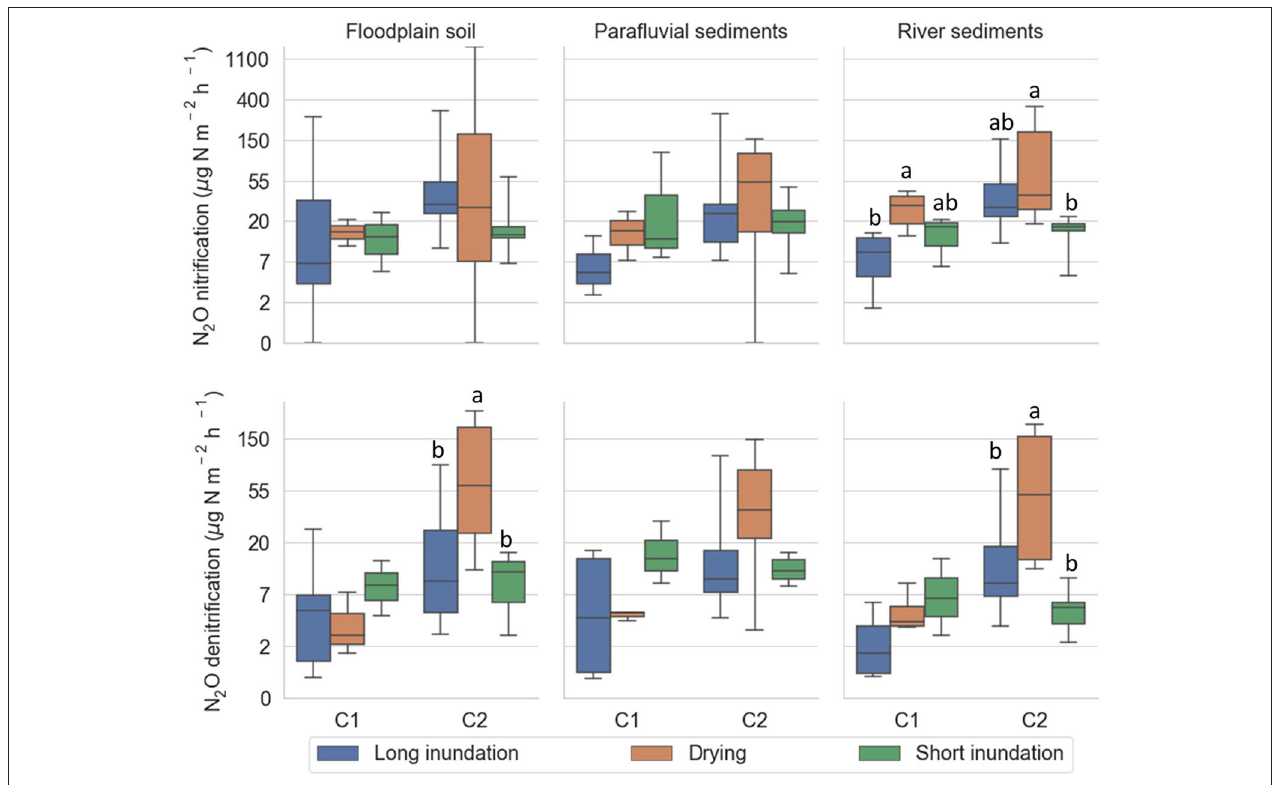
FIGURE 6 | N 2 O fluxes derived from nitrification (A) and denitrification (B) per site (floodplain soil, parafluvial sediments, river sediments), for each phase (long inundation, drying phase, short inundation phase). The data is aggregated by cycle (cycle 1 and 2). For each cycle, the treatment cores were subject to drying (orange; n = 6) and short inundation (green; n = 6) events. The control cores (blue; n = 12) were kept flooded throughout the entire experiment and were equally sampled at the same dates as the treatment cores. Error bars are the 95% confidence interval, the bottom and top of the box are the 25th and 75th percentiles, the line inside the box is the 50th percentile (median), and any outliers are shown as points.